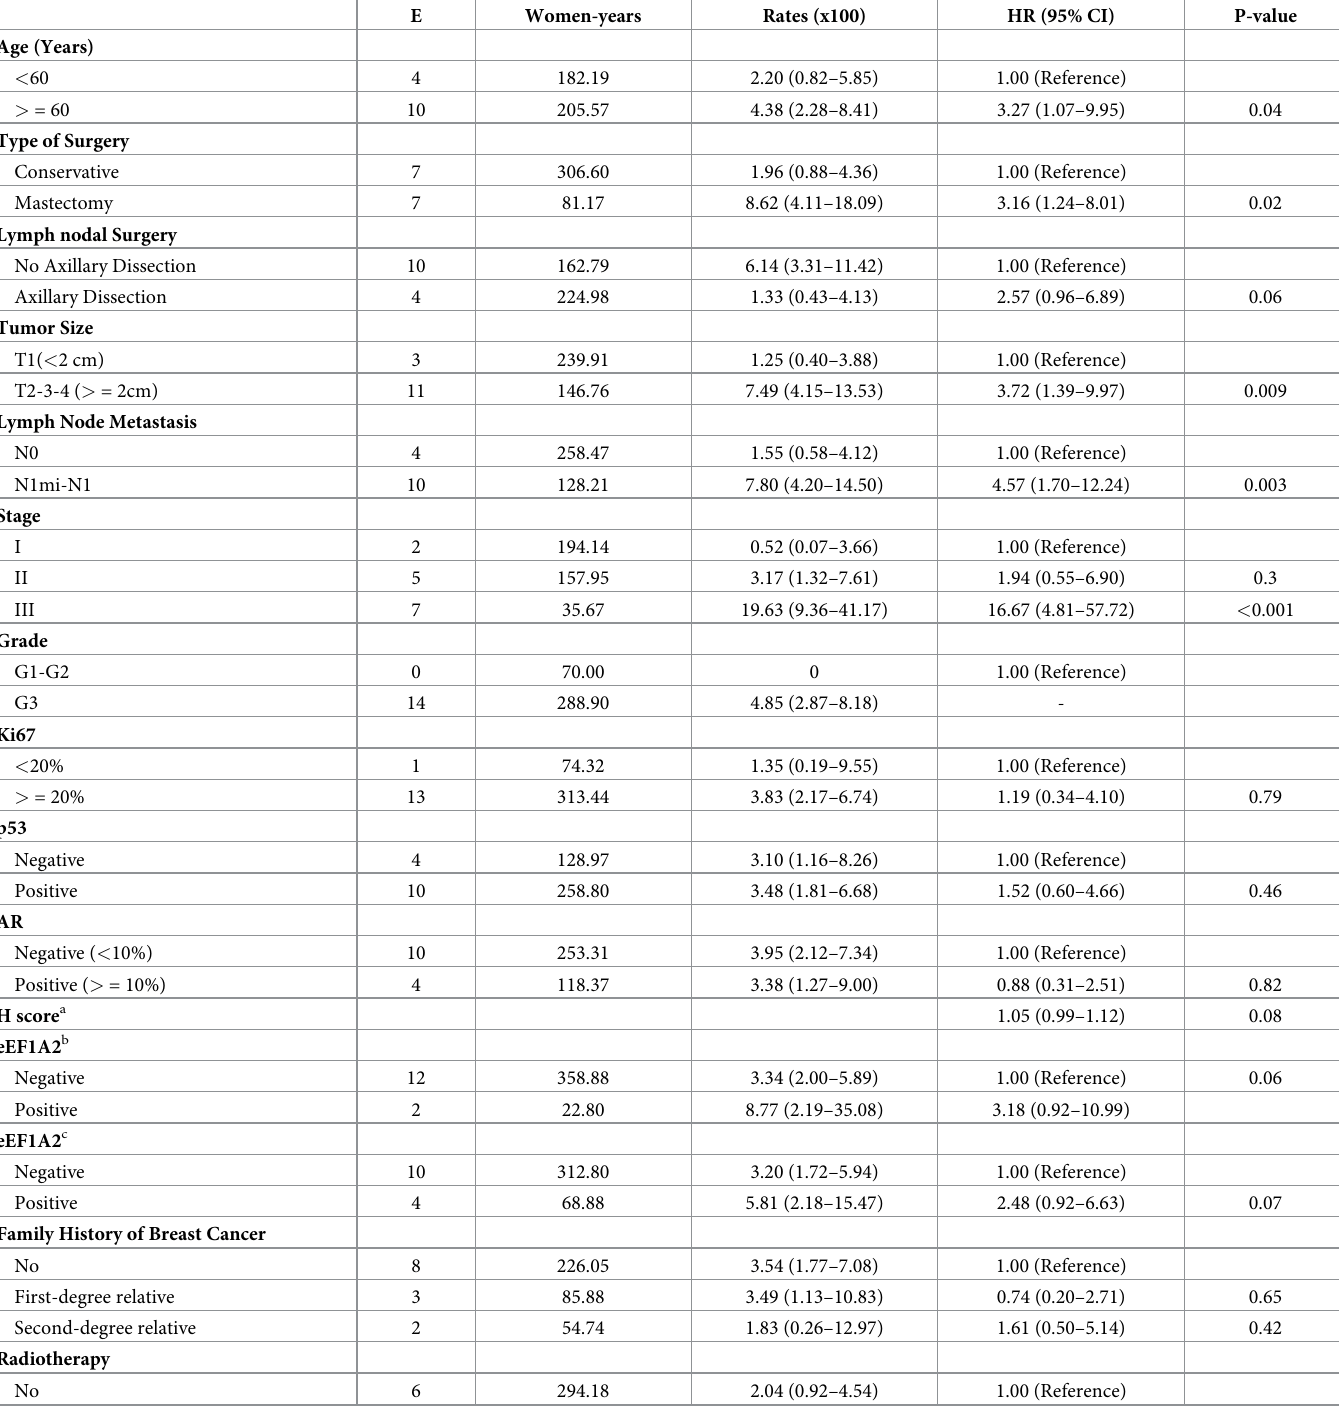
Table 4. Results from univariate Cox models for